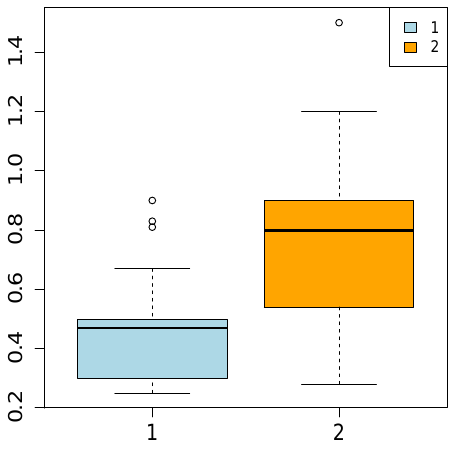
Figure 2. Boxplot of the variable “waste generation” in clusters 1 and 2.